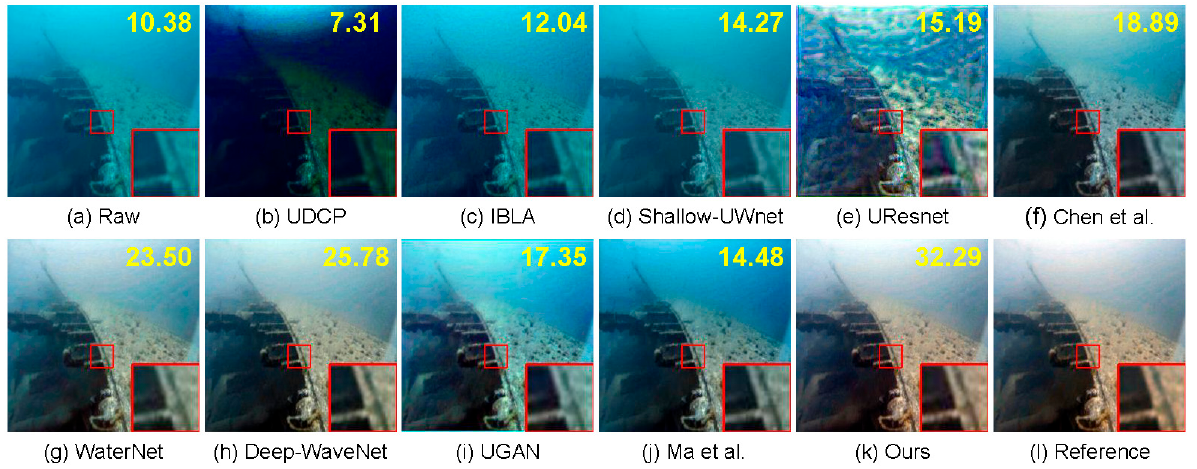
Figure 7. The visual comparisons of various UIE approaches on the bluish underwater images. The number on each image represents its PSNR score.